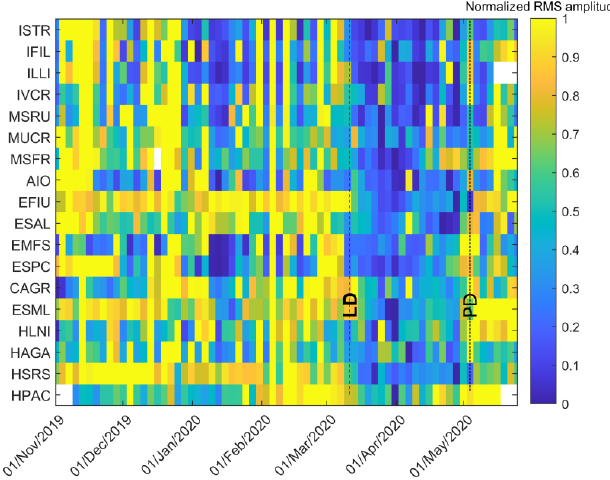
Figure 4. Temporal changes in the normalized seismic rms ampli- tude at 18 seismic stations sorted by decreasing latitude (see la- bels on the left y axis). Data gaps are coloured white. The verti- cal dashed lines and the labels “LD” and “PD” indicate the times when the national lockdown measures were implemented in Italy (11 March 2020) and when the first presidential decree, slightly lift- ing the lockdown measures, was issued (4 May 2020), respectively.